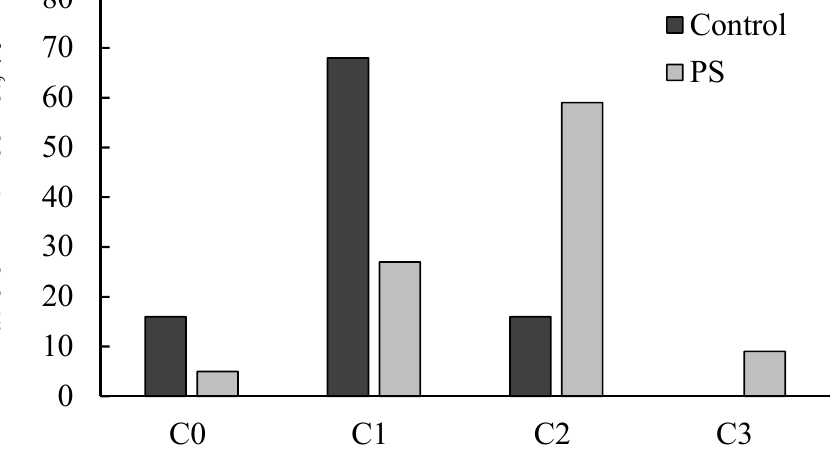
Figure 2. Induction of DNA strand breaks, represented as a percentage of comet damage classes in digestive gland cells from control and experimental groups (n = 12; n = 600).